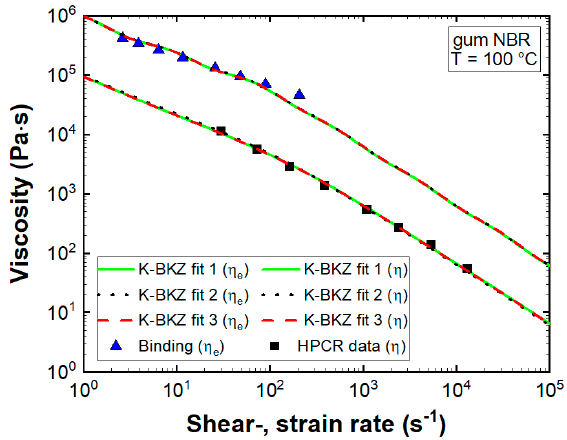
Figure 7. Steady-state shear ( η ) and uniaxial elongational ( η e ) viscosities of gum NBR compared to K-BKZ model predictions; K-BKZ fit 1 represents fitted LVE data measured at F n < 1 N ( θ = 0), K-BKZ fit 2 represents fitted LVE data measured at F n = 10 N ( θ = 0), and K-BKZ fit 3 represents fitted LVE data measured at F n < 1 N ( θ = − 0.15).